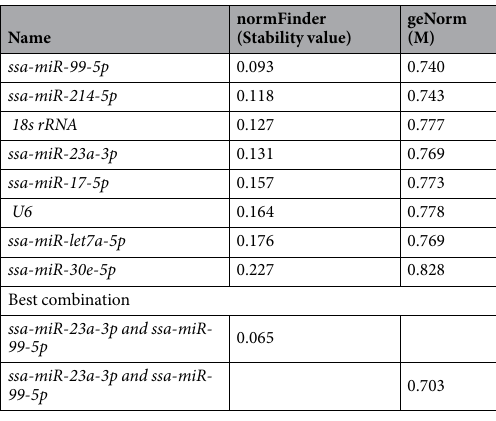
Table 4. Stability and M values for control